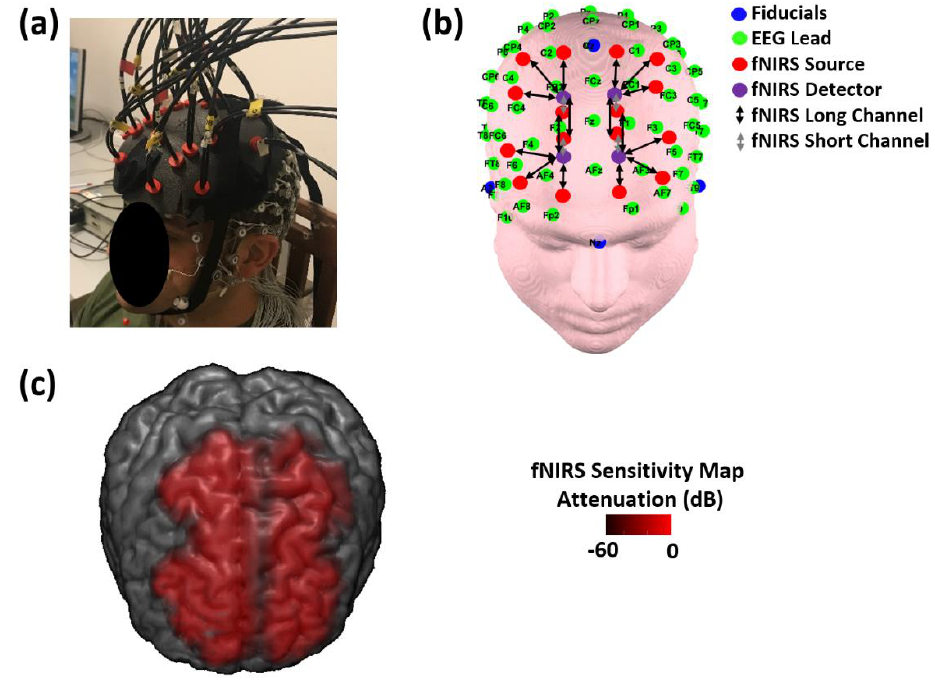
Figure 1. ( a ) Electroencephalography and functional near-infrared spectroscopy (EEG-fNIRS) probes located on a participant’s head. The fNIRS fiber heads reached the scalp using the spaces between the electrodes of the EEG cap. ( b ) EEG-fNIRS probes overlaid on a template head. The high-density (128-channel) EEG layout was arranged in agreement with the 10/20 system and the fNIRS probes were positioned with reference to the EEG sensors. ( c ) Channels’ average sensitivity map of the fNIRS measurements. The sensitivity map was computed using the finite element method to solve the diffusion equation [67] and it is displayed up to an attenuation of 60 dB from its maximum value.